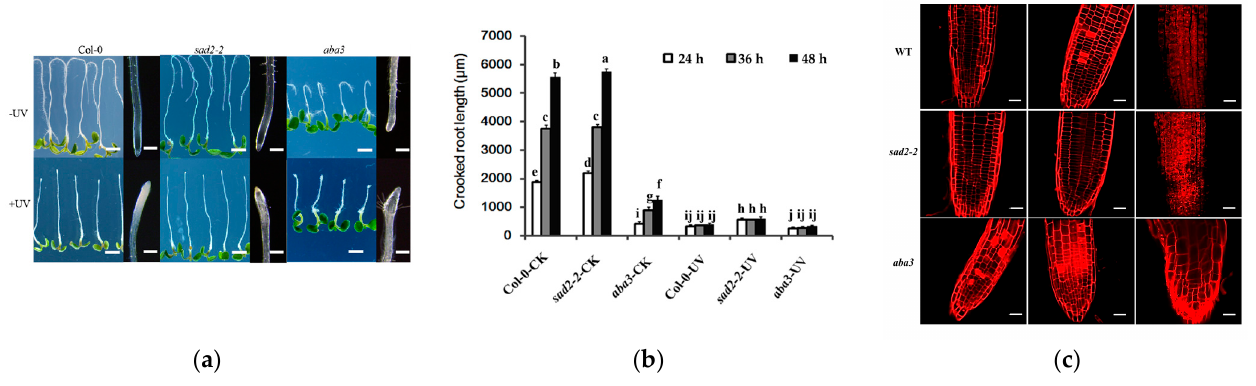
Figure 2. ABA deficiency aggravated the isotropic expansion of root tips induced by UV-B radiation. ( a ) Effects of UV-B radiation on the A. thaliana seedling growth. Six-day-old A. thaliana wild type (Col-0), sad2-2, and aba3 seedlings vertically grown in standard MS medium were irradiated with 90 mJ cm − 2 of UV-B light for 30 min and positioned upside down. The phenotypes of treated seedlings were photographed 48 h post-radiation, and the root tips were enlarged using a Zeiss LSM 510. META confocal microscope. Scale bars represent 2 mm for seedlings and 200 μ m for enlarged views of the root tips. ( b ) Effects of UV-B stress on root elongation of wild type and sad2-2 and aba3 mu- tants. The crooked root lengths of seedlings were measured, and those not exposed to UV-B radia- tion were used as controls (CK). All the statistical analyses were conducted using the IBM SPSS Statistics 27 software. All values are expressed as the mean ± SE ( n ≥ 20). And letters of a-j represent statistically significant groupings of p ≤ 0.05 based on a one-way ANOVA with the LSD multiple range tests. ( c ) The images of the root epidermal cells staining by Propidium Iodide (PI) in three genotype seedlings. Healthy six-day-old seedlings were arranged in MS medium containing 0.5 μ mol L − 1 ABA for two days or imposed by UV-B radiation for 30 min following one day of normal illumination. Then the root tips were stained with 5 μ g ml − 1 PI and photographed to show that ABA deficiency aggravated the root growth retardation and influenced root morphology. Scale bars rep- resent 30 μ m.